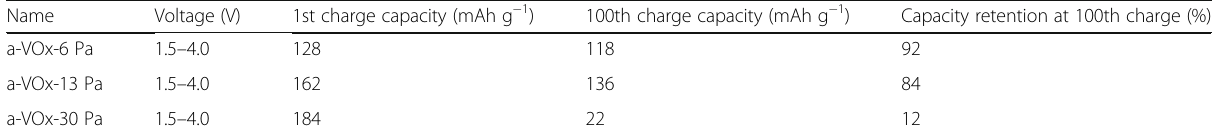
Table 5 Na-ion battery cycling performance of a-VOx films and at 0.1 C current